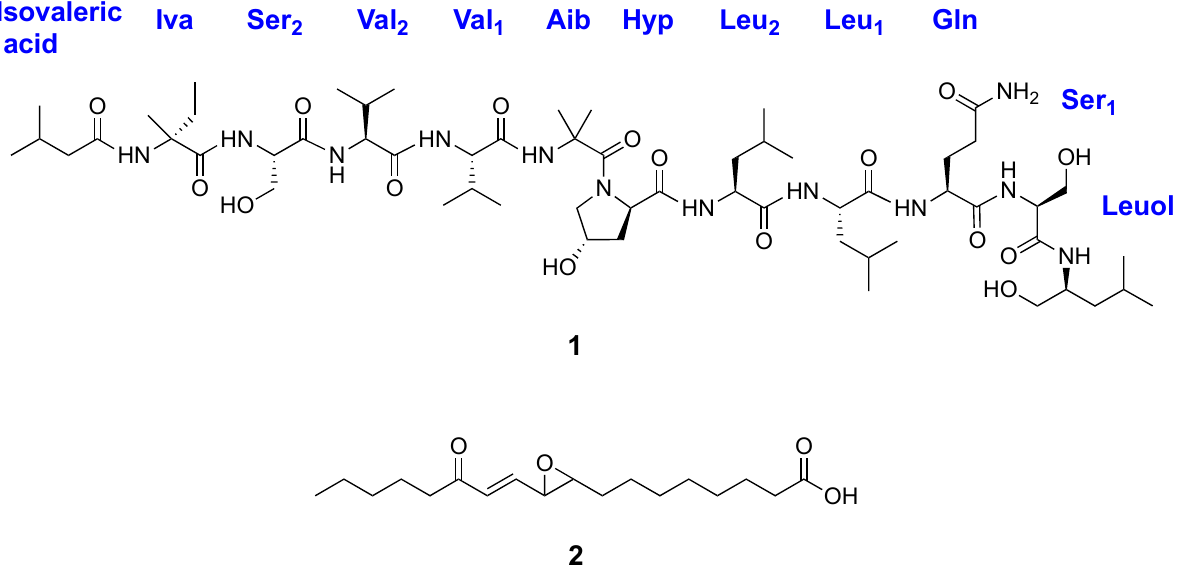
Figure 1. Structures of roseabol A ( 1 ) and 13 ‐ oxo ‐ trans ‐ 9,10 ‐ epoxy ‐ 11( E ) ‐ octadecenoic acid ( 2 ).